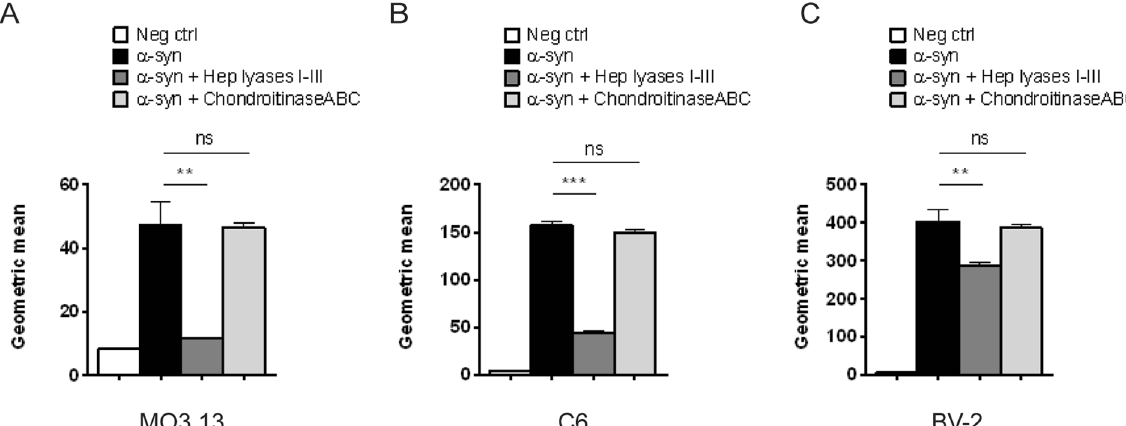
Figure 5. The involvement of heparan sulfate in internalization of α -synuclein fibrils in different types of glial cell lines. The cell lines were treated with a mix of heparin lyases I, II and III or chondroitinase ABC (5 mU/ ml) before pHrodo- α -synuclein fibrils were added to the cell media. Internalization was measured by flow cytometry after incubation with pHrodo- α -synuclein fibrils for 8 hr. ( A ) Internalization of pHrodo- α -synuclein fibrils in the oligodendrocytic human MO3.13 cell line. ( B ) Internalization of pHrodo- α -synuclein fibrils in the astrocyte-like rat glioma C6 cell line. ( C ) Internalization of pHrodo- α -synuclein fibrils in the mouse microglial BV2 cell line. Statistical significance was analyzed by Student’s